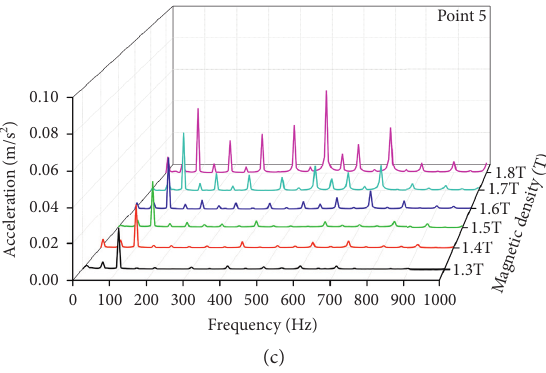
Figure 13: Vibration characteristics of measurement points 2, 3, and 5 under different magnetic